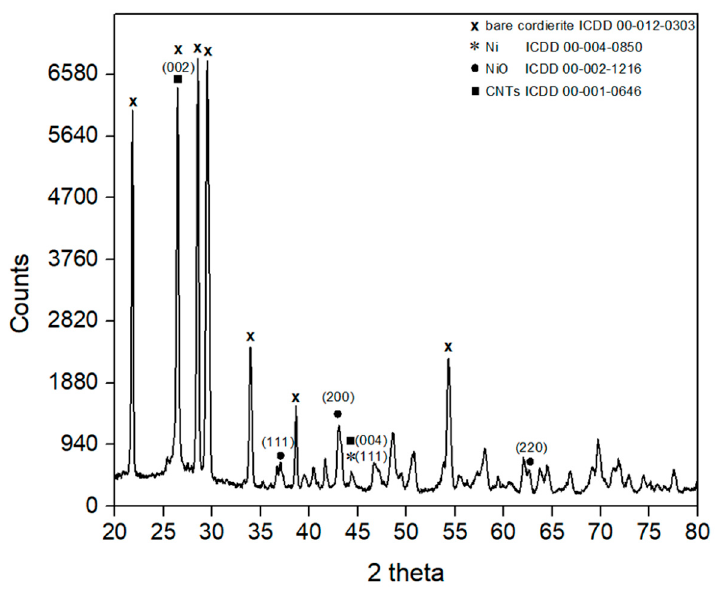
Figure 7. XRD pattern of CNT monolith at optimum condition.